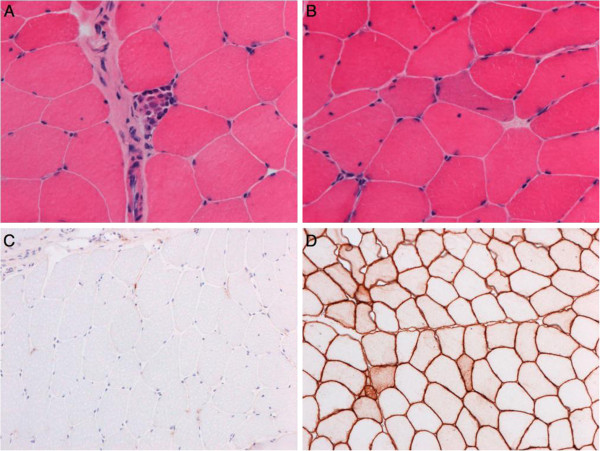
Histology of the muscle biopsy. Histology showed foci of necrotic fibres infiltrated by inflammatory cells (A, H&E); basophilic cells reminiscent of regeneration (B, H&E); almost complete loss of dysferlin reactivity (C) with maintained caveolin-3 reactivity (D).